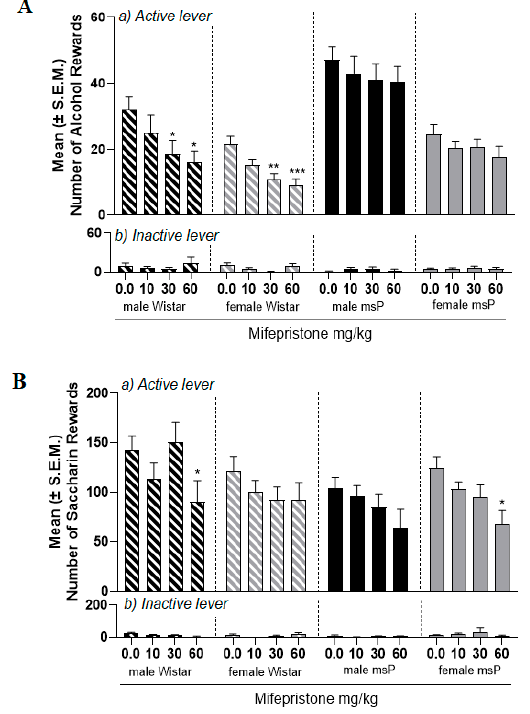
Figure 1. Effect of mifepristone on alcohol and saccharin self-administration in male and female msP and Wistar rats. Male and female msP and Wistar rats were treated with mifepristone (0.0, 10, 30 and 60 mg/kg) i.p., 90 min prior to test session. ( A ) Mifepristone treatment significantly reduced the number of alcohol rewards in male and female Wistars. Drug treatment did not decrease alcohol SA in male and female msPs. ( B ) At the dose of 60 mg/kg, mifepristone significantly reduced saccharin SA in male Wistars and in female msPs. Data are expressed as the mean ± SEM of number of: ( a ) reinforced responses (rewards) at the active lever and ( b ) total responses at the inactive lever. Significant difference from vehicle (0.0 mg/kg): * p < 0.05; ** p < 0.01; *** p <